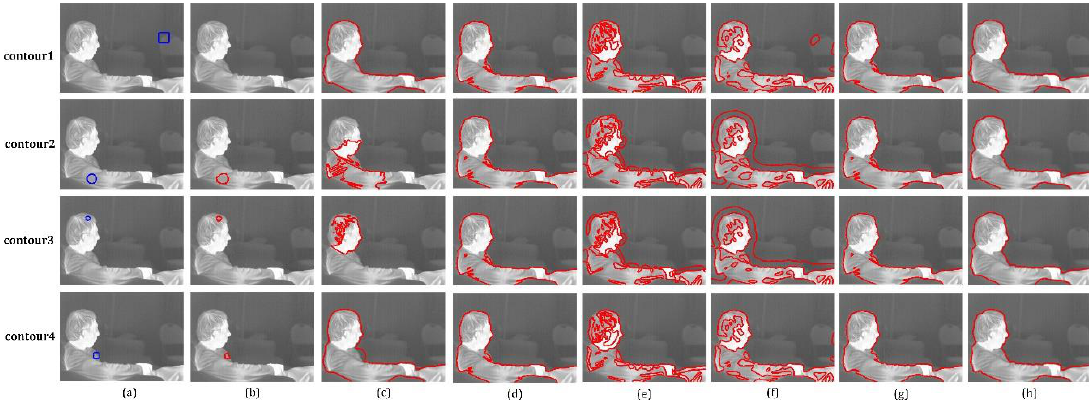
Figure 16. Segmentation results for ‘man’ image with different initial contours: ( a ) initial contour; ( b ) GAC; ( c ) CV; ( d ) SBGFRLS; ( e ) LBF; ( f ) ILFE; ( g ) Cao’s model; ( h ) the proposed method.